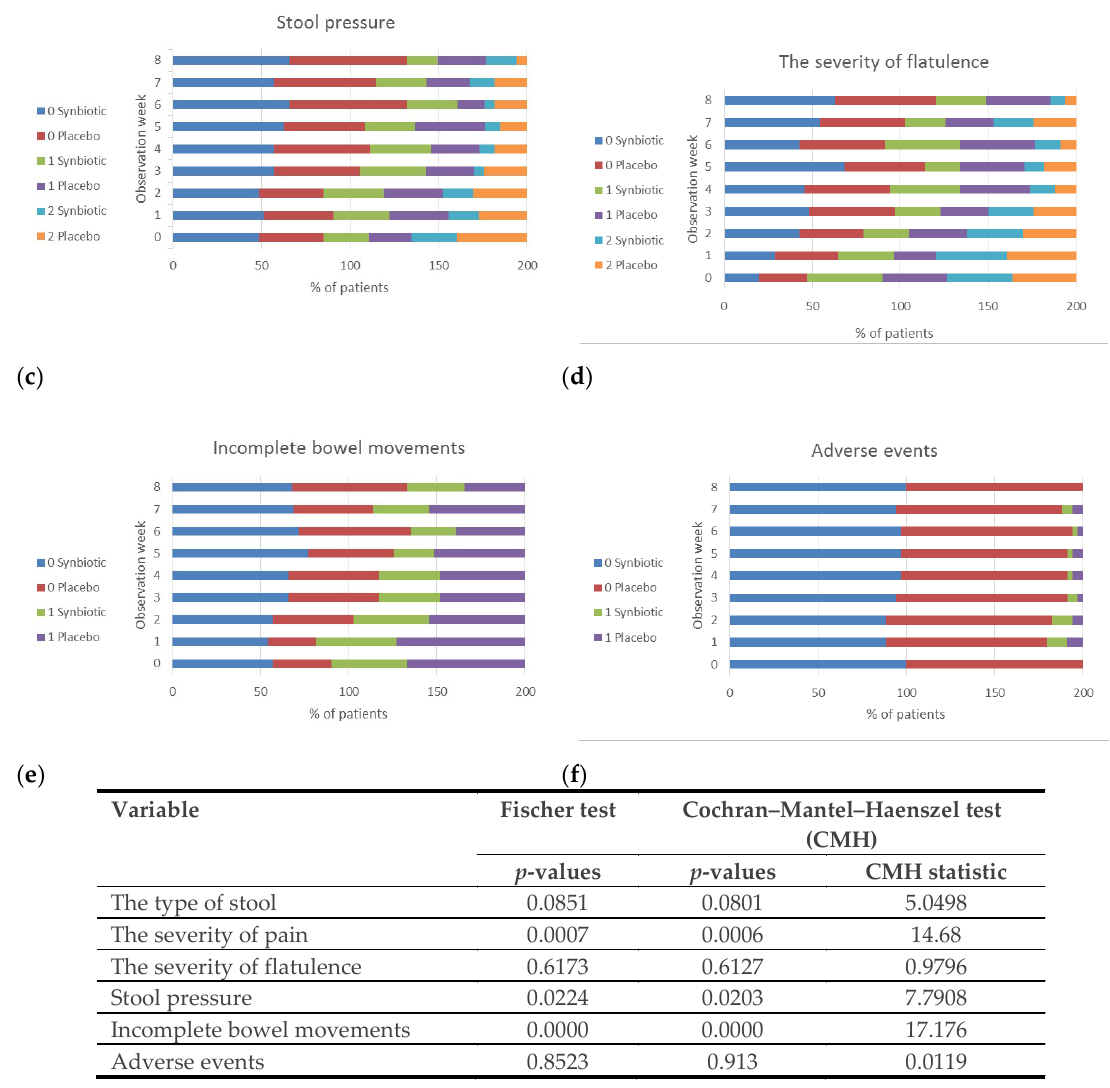
Figure 5. The impact of synbiotics on ( a ) the type of stool, ( b ) the severity of pain, ( c ) stool pressure, ( d ) the severity of flatulence, ( e ) incomplete bowel movements, ( f ) adverse events assessed by telephone interviewers. All data were collected during telephone interviews. Week 0—screening week before enrollment into the study (baseline). Results are presented as a percentage of patients who reported the severity of symptoms accordingly transformed into new scales described in Table 2. The table ( g ) presents p -values of a Fisher exact test and Cochran–Mantel–Haenszel test (CHM) and CHM statistic. 0 Synbiotic/0 Placebo—constipation, no or weak pain, flatulence and stool pressure, no feeling of incomplete bowel movements, no adverse events in the synbiotic/placebo group; 1 Synbiotic/1 Placebo—normal stool, intermediate pain, flatulence and stool pressure, presence of a feeling of incomplete bowel movements, presence of adverse events in the synbiotic/placebo group; 2 Synbiotic/2 Placebo—diarrhea, severe pain,